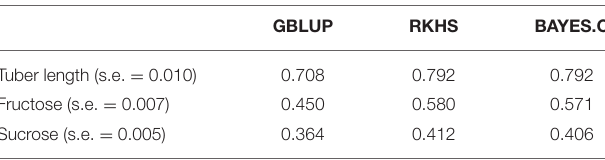
TABLE 4 | Marginal means and standard errors for prediction accuracy for varying combinations of statistical model (columns) and trait